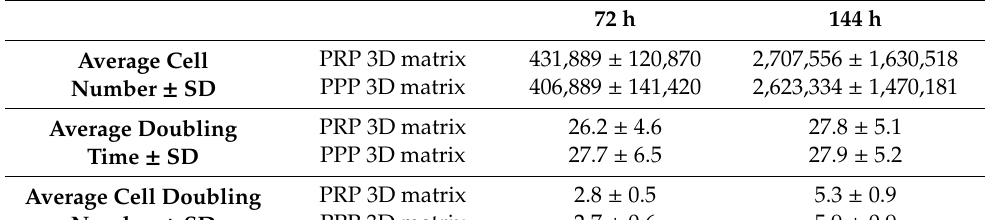
spreading over the entire thickness. No morphological differences are observed between cells maintained in PRP or platelet-poor plasma (PPP) derived matrix.